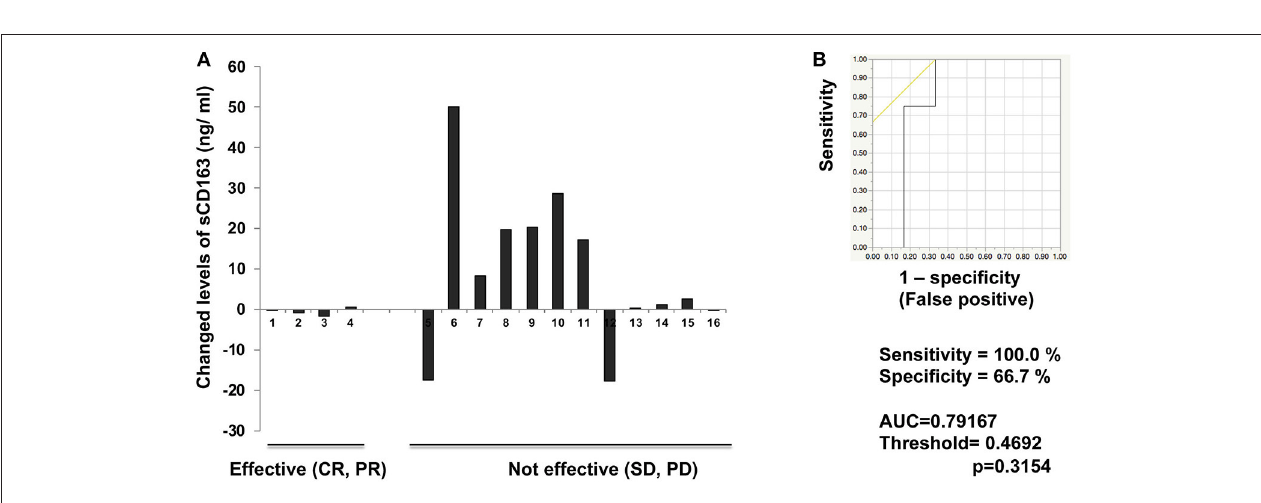
FIGURE 2 | Serum levels of sCD163 and ROC curve in non-cutaneous melanoma. Serum level changes of sCD163 in each patient ( n = 16) (A) on day 42. The ROC curve was applied to calculate cut-offs for sCD163 serum levels and AUC (B) . Cut-offs were determined to distinguish responders from nonresponders using Youden’s